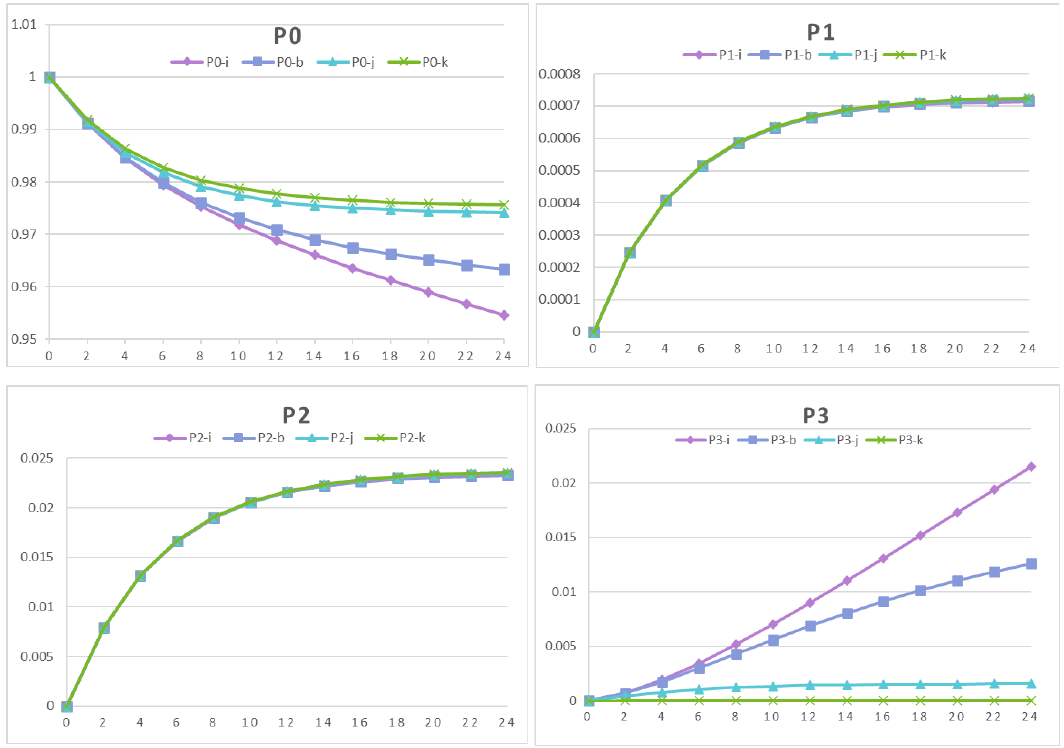
Figure 8. Probabilities of each disk state for different rescue mechanisms r fg ( x -axis: mission time).